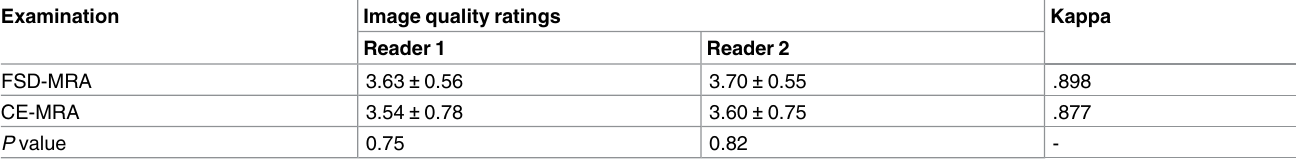
Table 3. Comparison of image quality ratings and inter-observer agreement (Kappa).